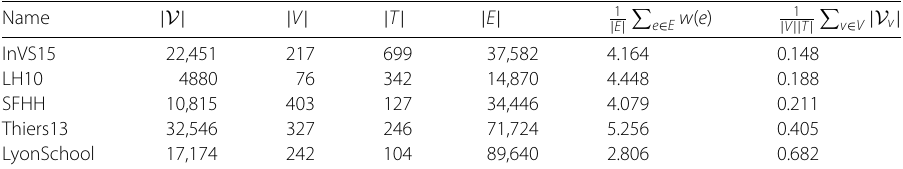
Table 1 Empirical temporal networks. Columns, from leftmost to rightmost: data set name, number of active nodes, number of nodes, number of timestamps, number of temporal edges, average weight of temporal edges, average fraction of timestamps in which a node is